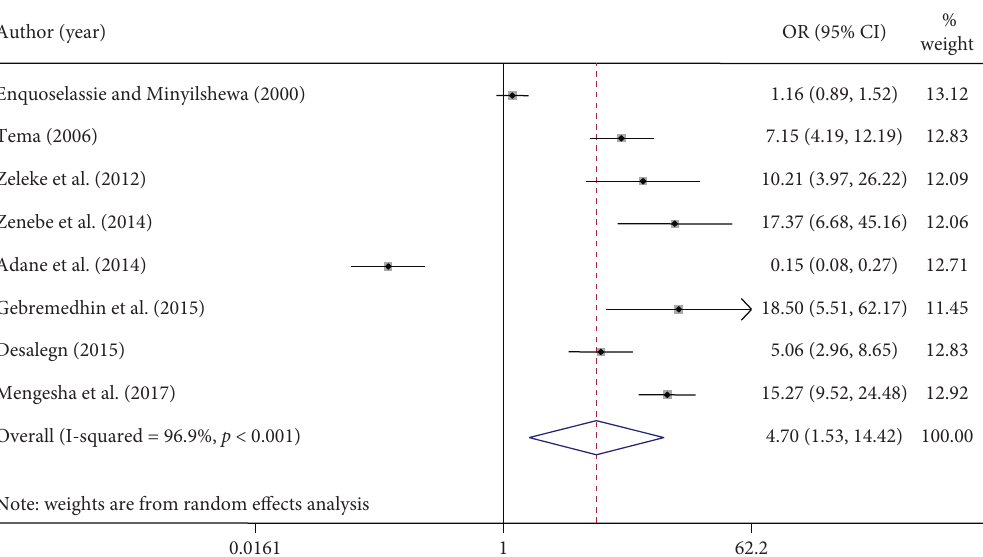
Figure 5: Forest plot displaying the association of preterm delivery before 37 weeks of gestation and low birth weight